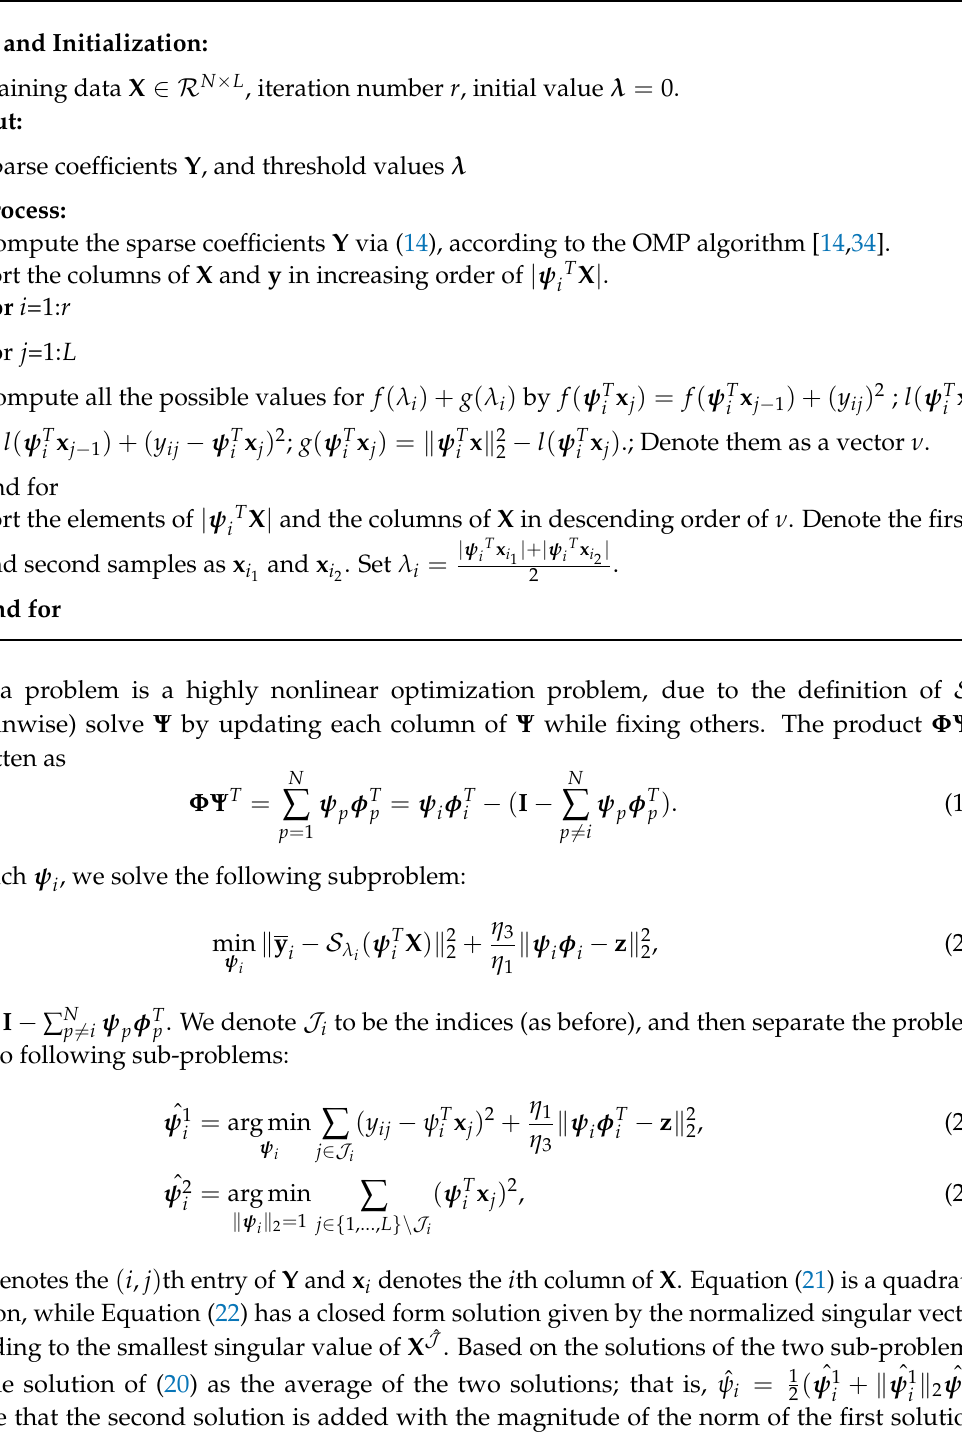
Algorithm 1: Sparse coding